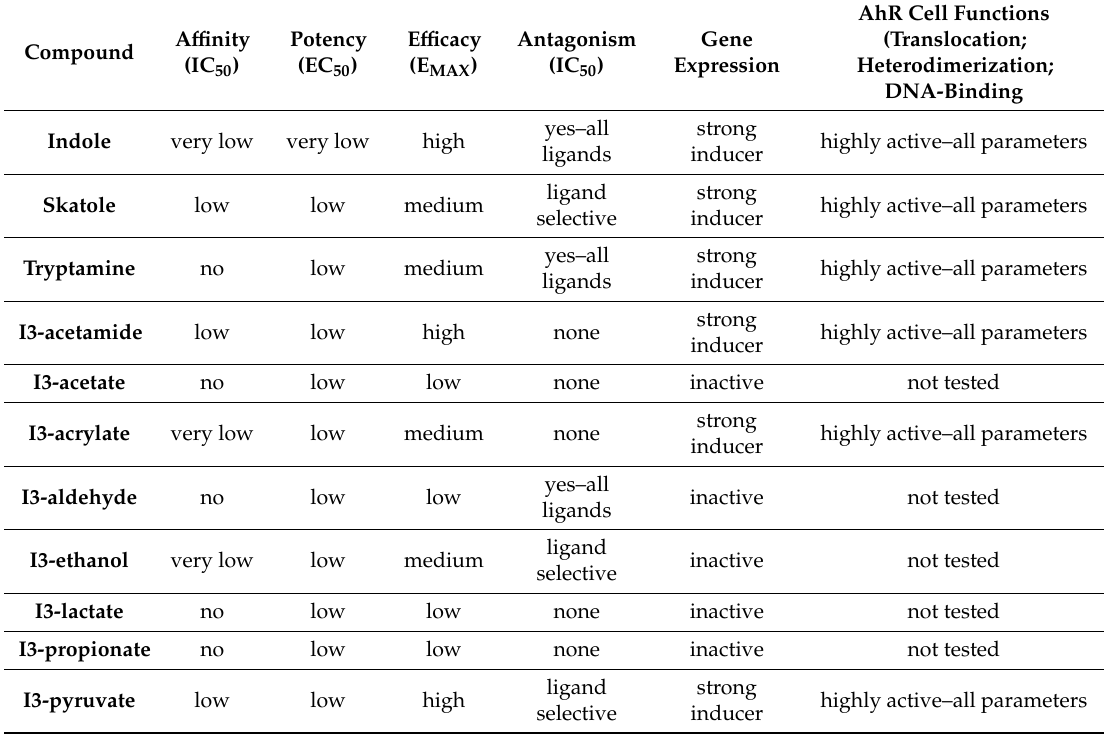
Table 1. Summary of MICT e ff ects on the AhR–CYP1A1